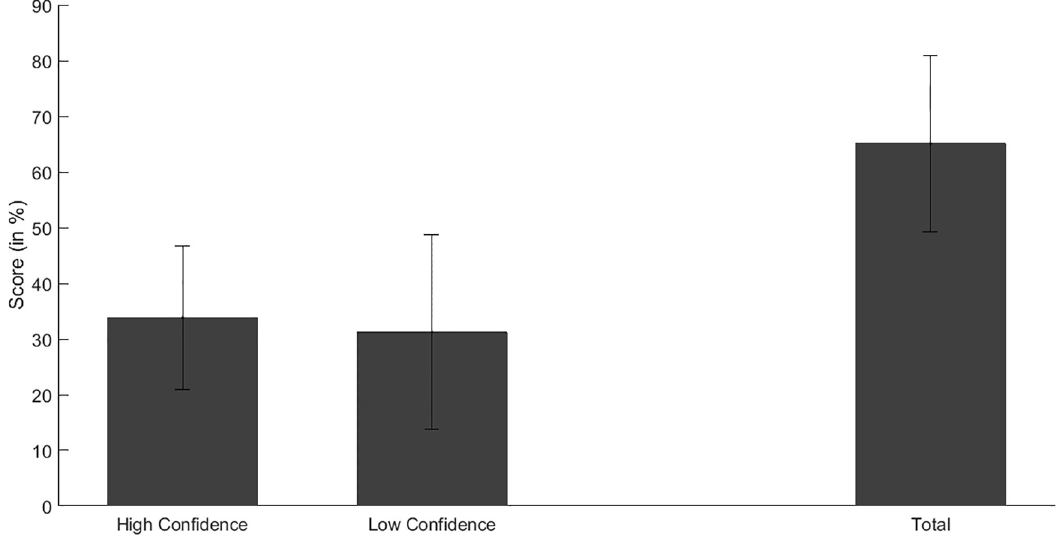
Fig 2. Behavioral results. Within the group of implicit participants, mean completion task performance (in percentage) for correct responses is shown: correct responses with high confidence, correct responses with low confidence, and total amount of correct responses (from left to right). Error bars denote the standard deviation. No significant difference between high and low confidence scores was found.